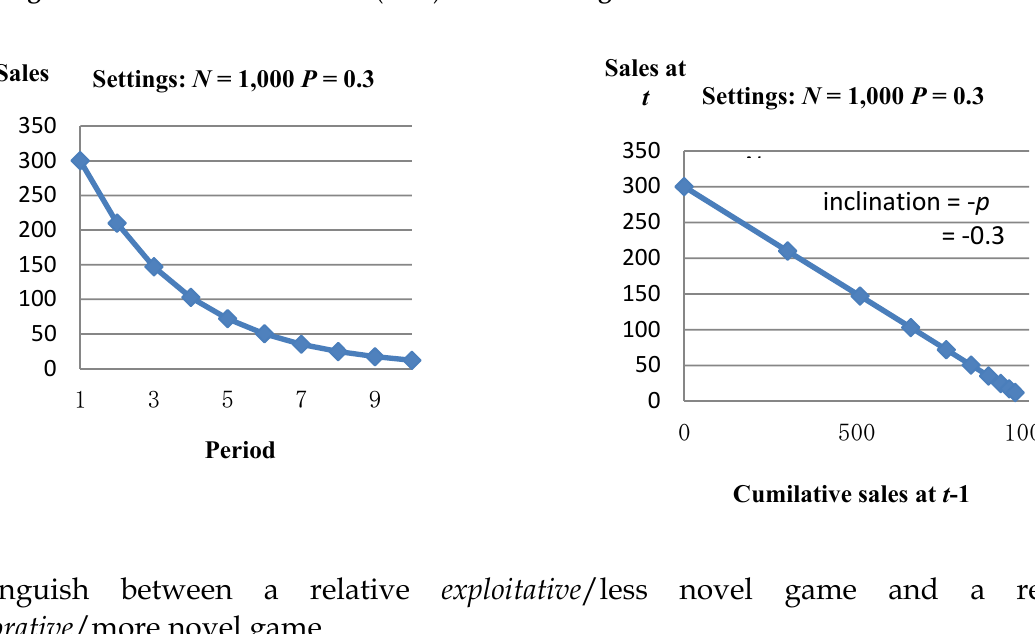
Figure 4. Fourt-Woodlock model (1960) Figure 5. Transformed Fourt-Woodlock